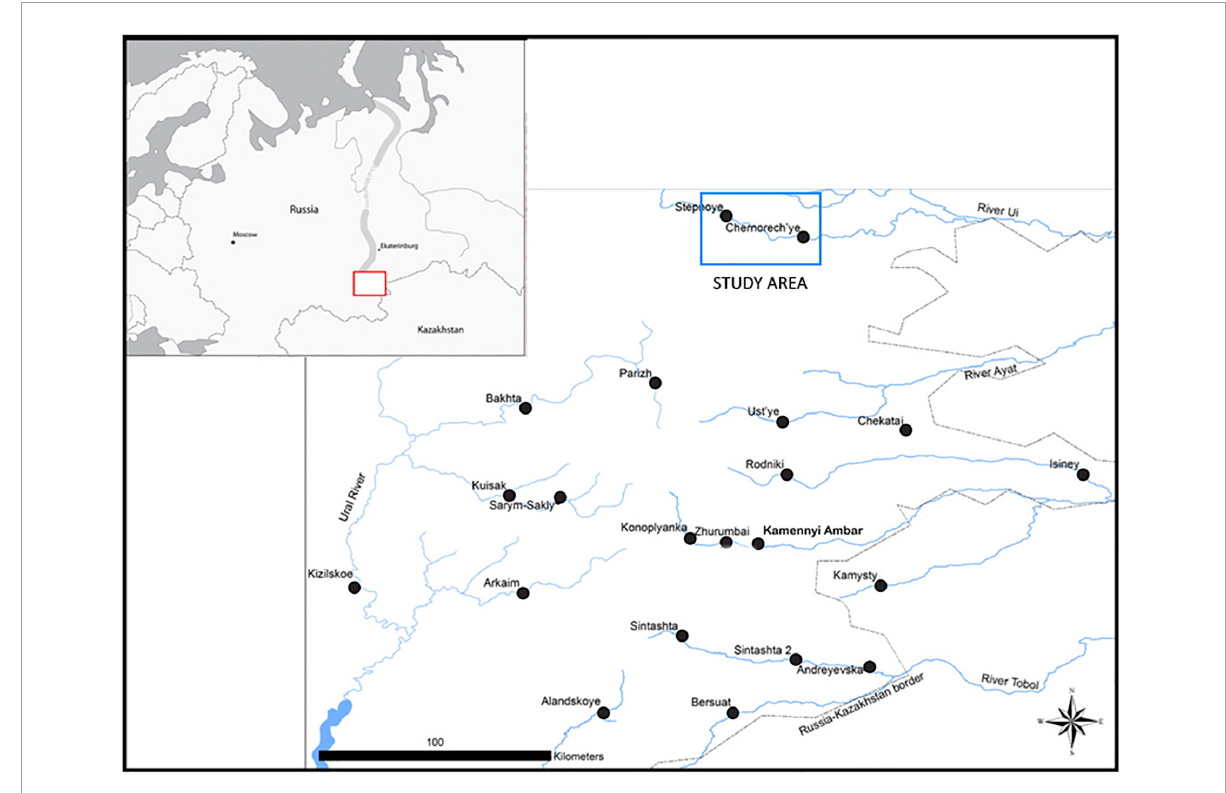
FIGURE1 Map of enclosed Bronze Age settlements and Study area in the Southeastern Urals [modified from Doonan et al. (2014, p.